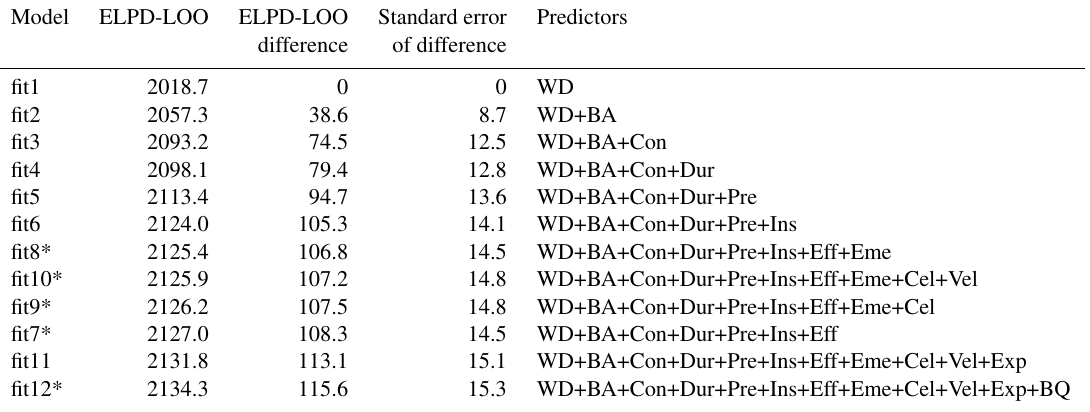
Table 3. Comparison of flood-type model candidates of differing complexity and using their expected log pointwise predictive density (ELPD-LOO), ranked by increasing predictive accuracy, along with differences and their standard errors with reference to model “fit1” (see Table S1 for all model variants).